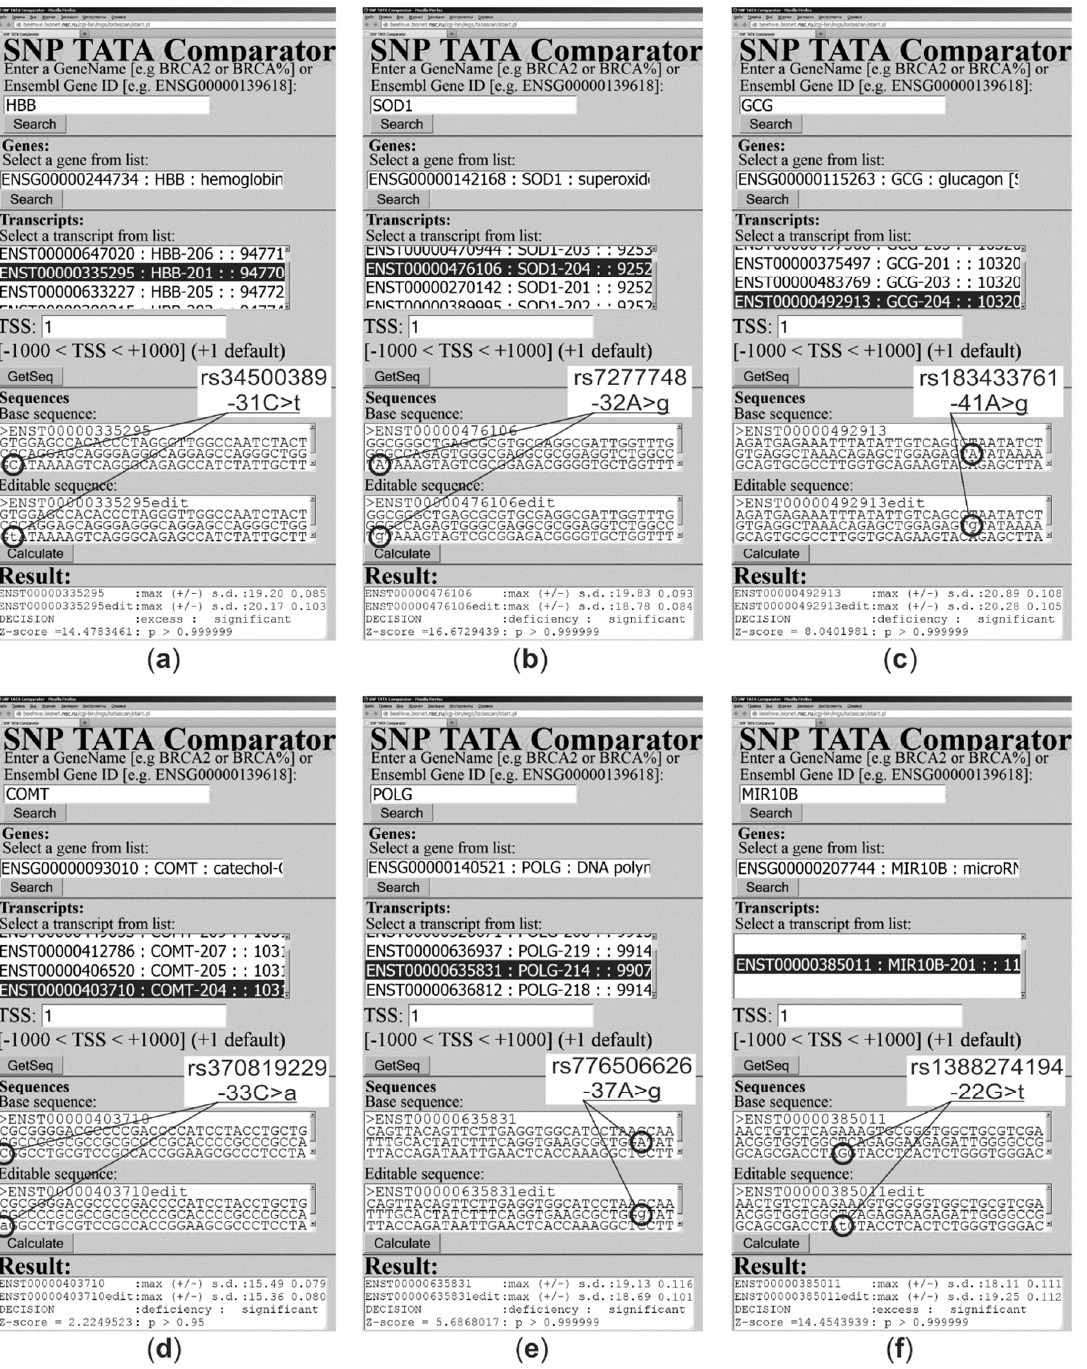
Figure 2. Examples of predictions made in this work (using our previously created Web service SNP_TATA_Comparator [45]) regarding statistically significant changes in the expression of human genes. Legend : See the footnote of Figure 1. Candidate SNP markers of accelerated and retarded atherogenesis: ( a ) HBB : rs34500389: − 31C > T; ( b ) SOD1 : rs7277748: − 32A > G; ( c ) GCG: rs183433761: − 41A > G; ( d ) COMT : rs370819229: − 33C > A; ( e ) POLG : rs776506626: − 37A > G; ( f ) MIR10B : rs1388274194: − 22G > T.